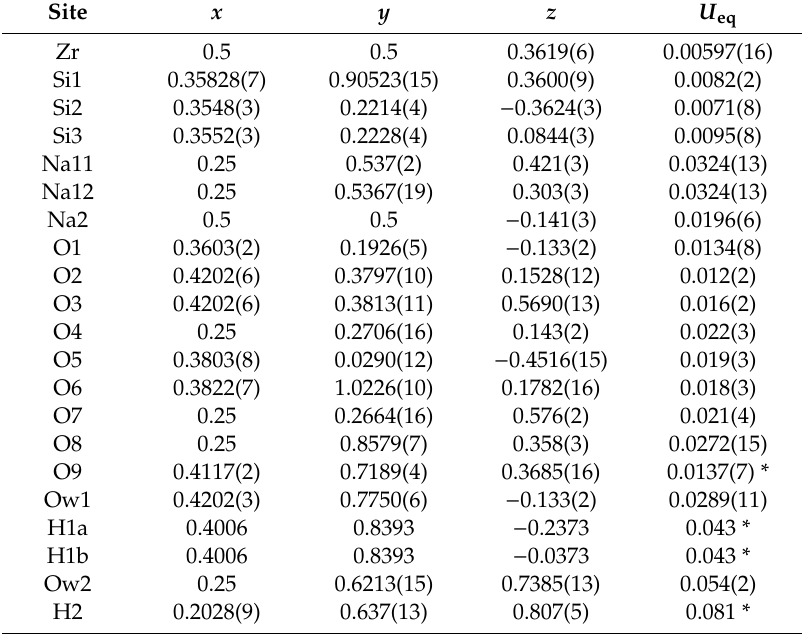
Table 4. Atom coordinates and equivalent displacement parameters (in Å 2 ) for initial elpidite from